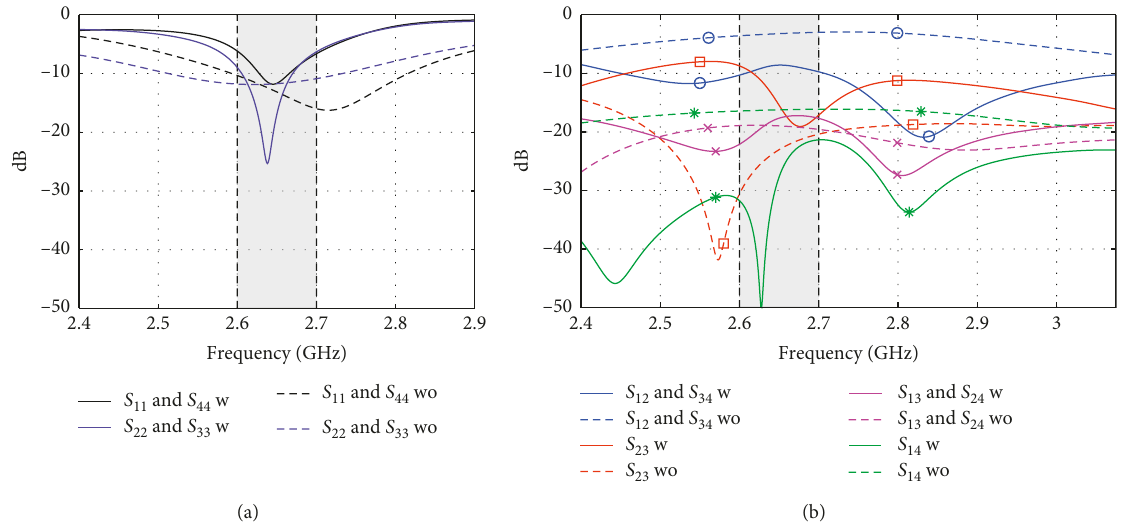
Figure 6: Simulated scattering parameters with (w) and without (wo) the DMN: (a) the reflection and (b) the coupling of the